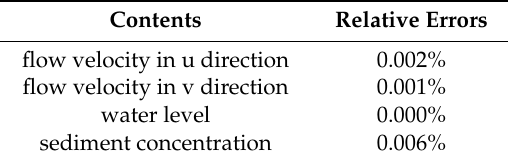
Table 2. Relative errors of the results between two